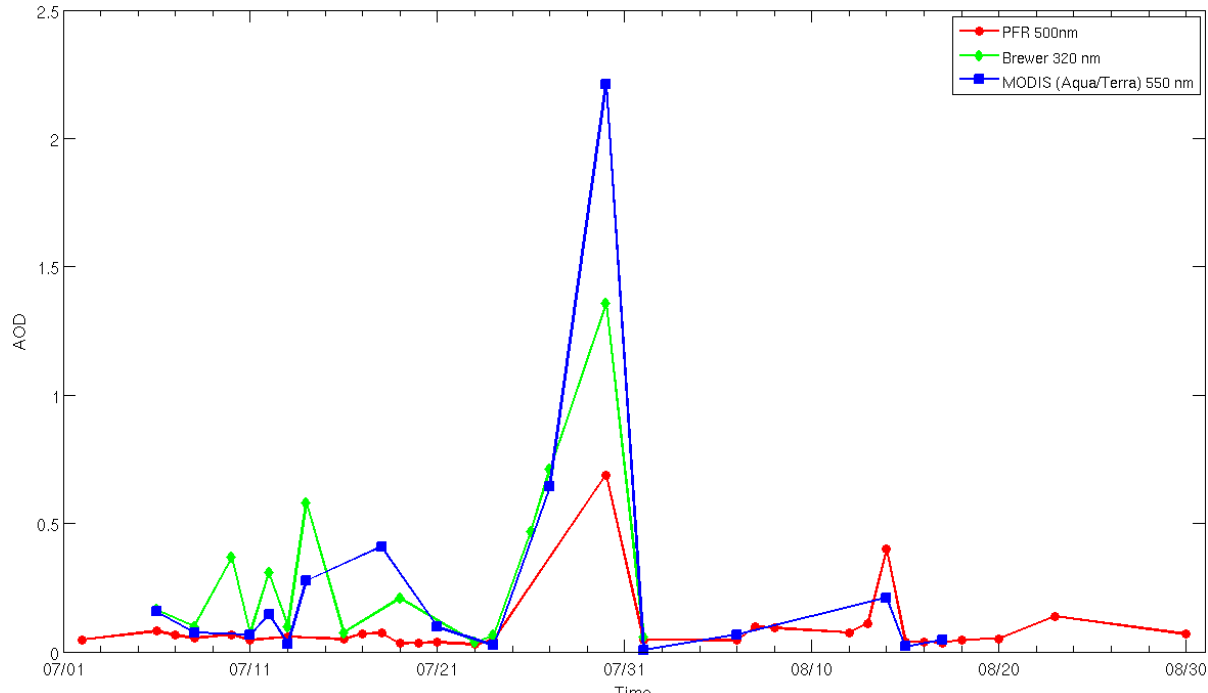
Figure 5. Daily averaged AOD values for Sodankylä from three instruments: PFR (500 nm), Brewer (320 nm) and MODIS (550 nm).